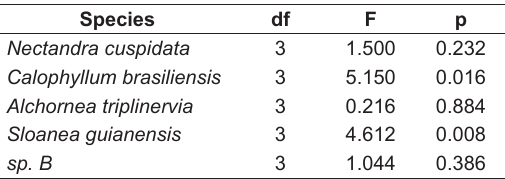
Figure 2. Mean (box) and standard deviation (line) in caloric content of leaves from tree species from CES riparian areas. Sg = Sloanea guianensis ; Nc = Nectandra cuspidata ; Cb = Calophyllum brasiliensis ; At = Alchornea triplinervia ; sp. B = specie of the Bignoniaceae family. Table 2. ANOVA test for seasonal variation of caloric content (KJ.g –1 ) for each species of CES riparian